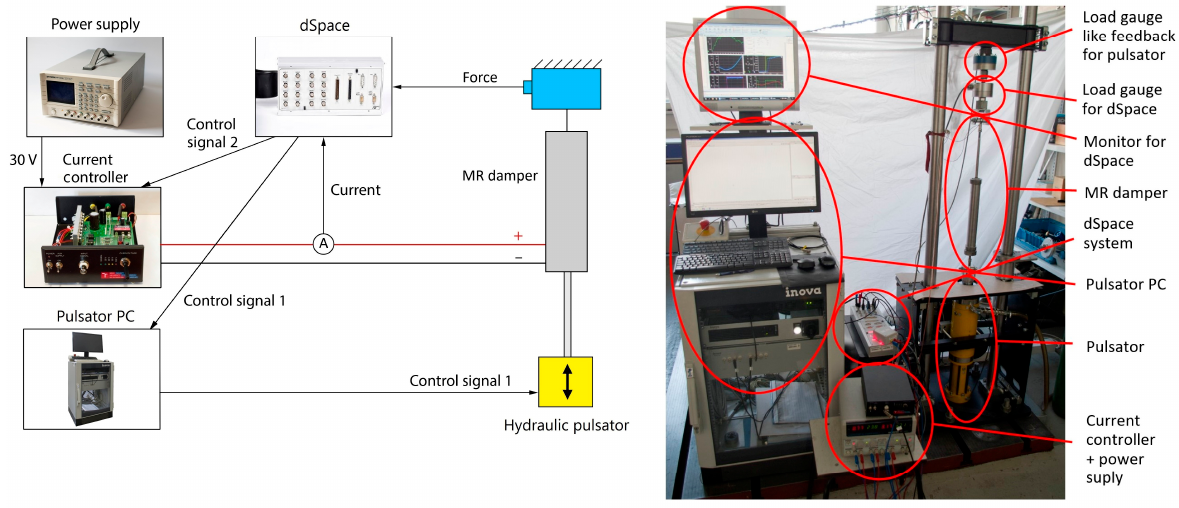
Figure 3. Experimental setup for HILS ( left ), HILS assembly ( right ).